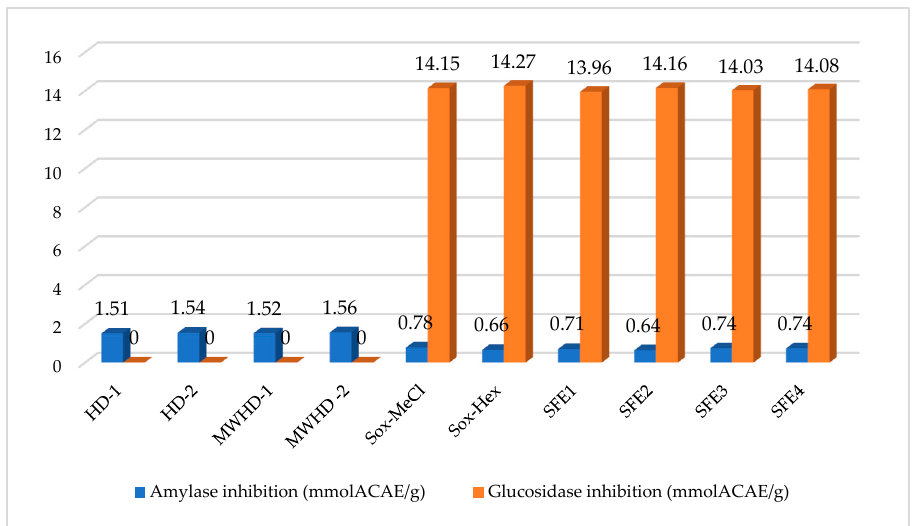
Figure 6. Amylase and glucosidase inhibition activity of chamomile extracts and essential oils obtained by various extraction and distillation techniques.